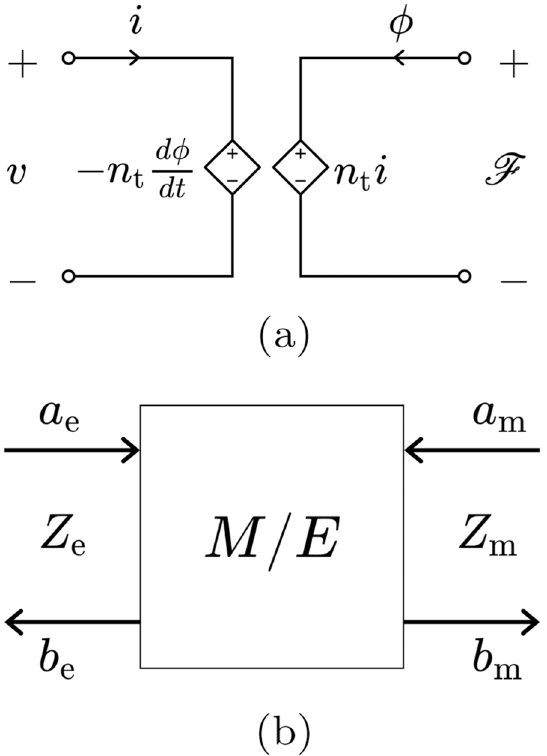
Fig. 2 Magnetic/electric junction a in the Kirchhoff domain and b in the wave digital